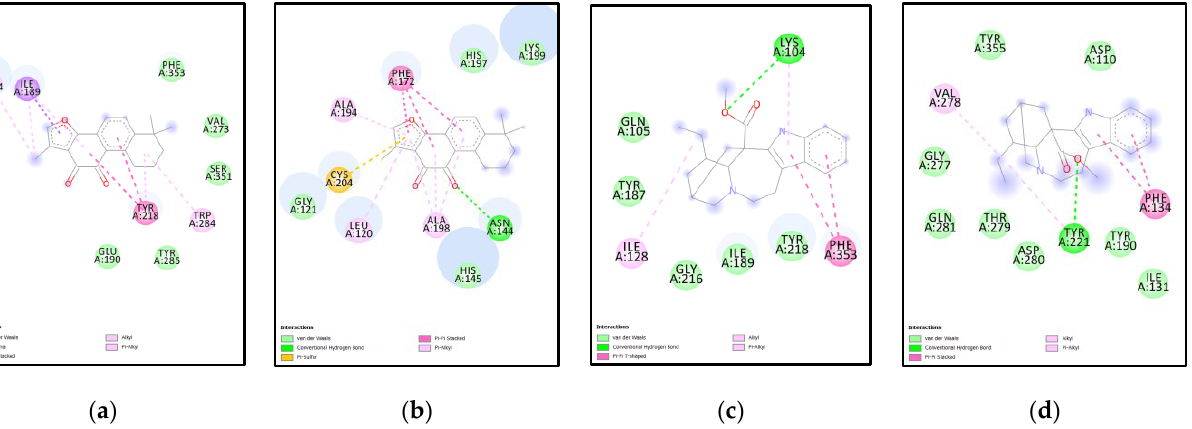
Figure 12. Ligplot showing amino acid residues involved in ligand-protein interactions for XP & XM ( a ) XP-Tanshinone 2 interacting amino acid residues ( b ) XM-Tanshinone 2 interacting amino acid residues ( c ) XP-Catharanthine interacting amino acid residues ( d ) XM-Catharanthine interacting amino acid residues.